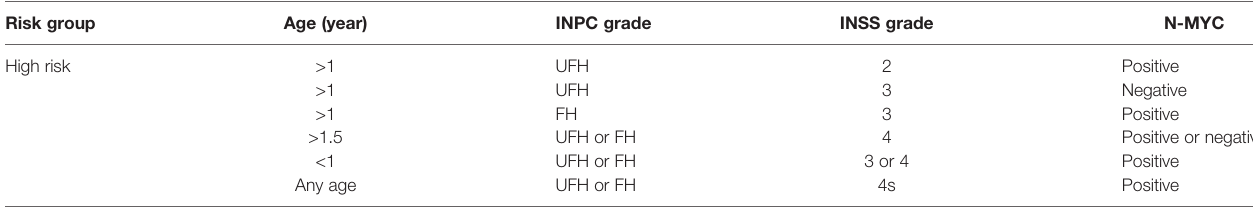
TABLE 1 | De fi nition of high-risk neuroblastoma according to the Children ’ s Oncology Group